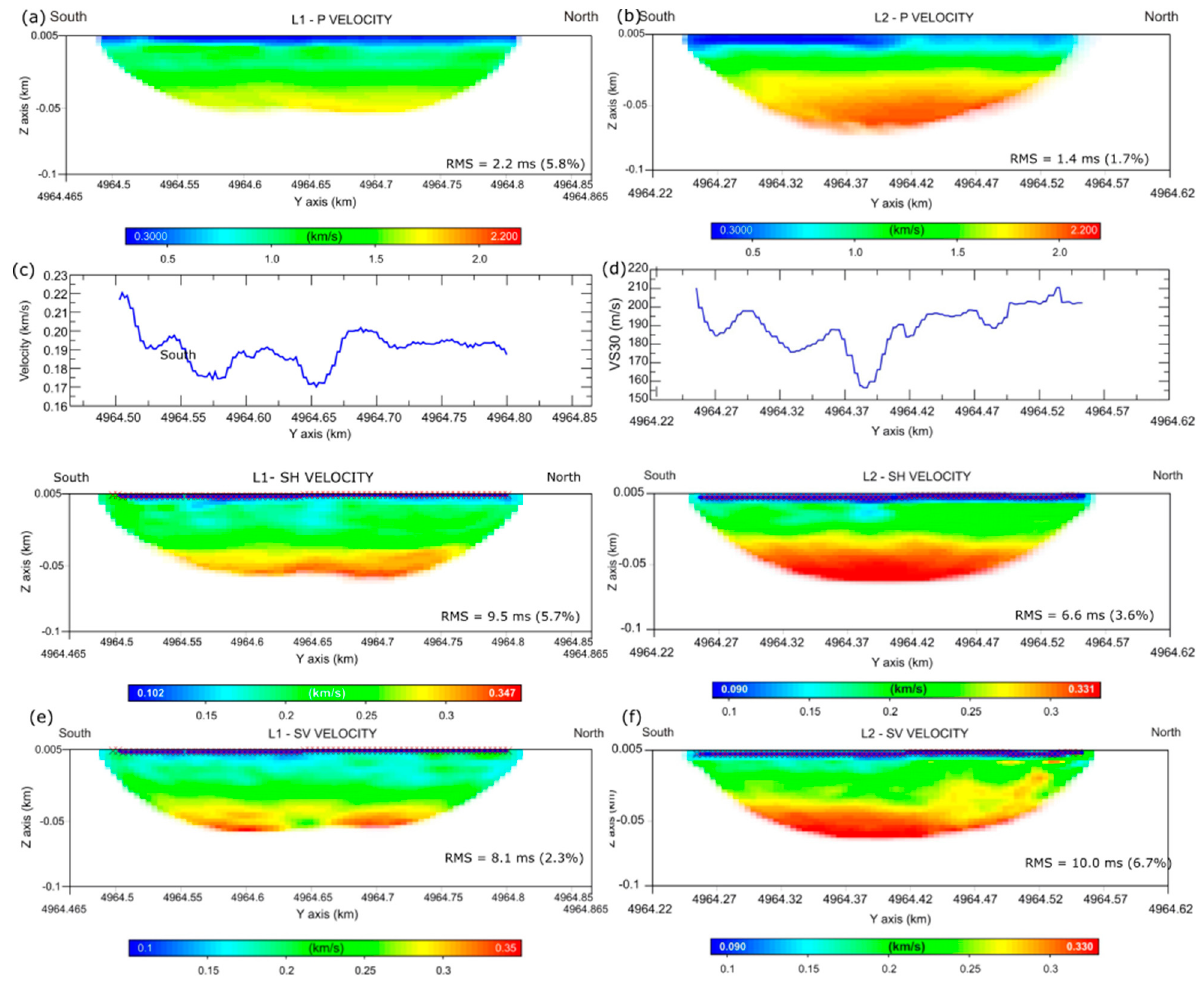
Figure 5. Velocity profiles from the Italian site; in the bottom-right corner, the value of the mean RMS error is shown. ( a ) Line 1 P-waves, ( b ) Line 2 P-waves, ( c ) Line 1 SH-waves with V S30 , ( d ) Line 2 SH-waves with V S30 , ( e ) Line 1 SV-waves, ( f ) Line 2 SV-waves.